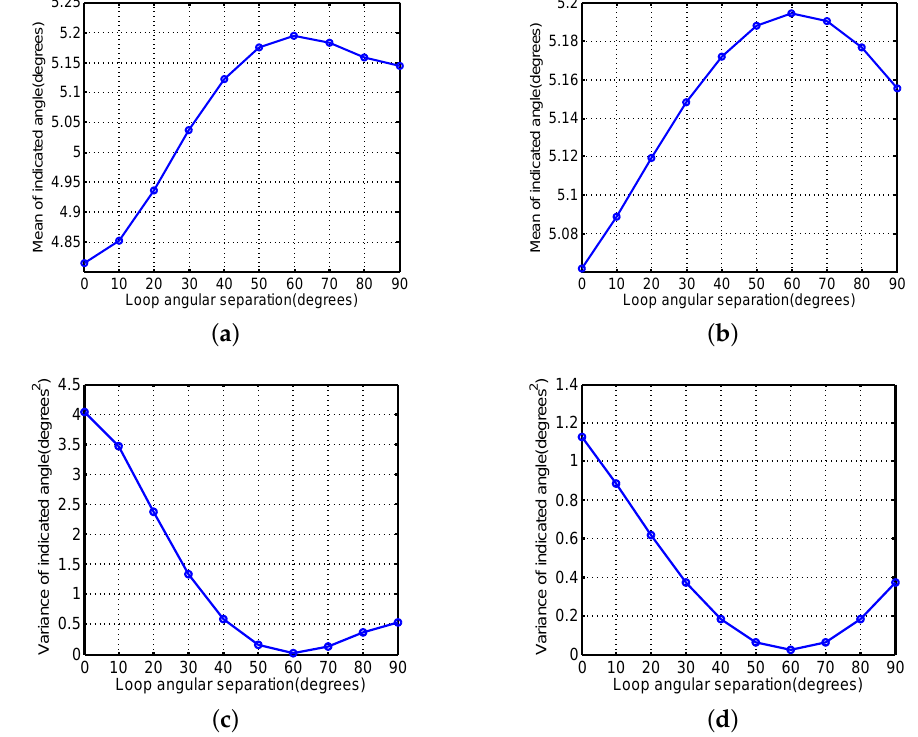
Figure 12. The arithmetic mean and variance of monopulse-indicated angle. ( a ) Arithmetic mean for the symmetrical case. ( b ) Arithmetic mean for the asymmetrical case. ( c ) Variance for the symmetrical case. ( d ) Variance for the asymmetrical case.